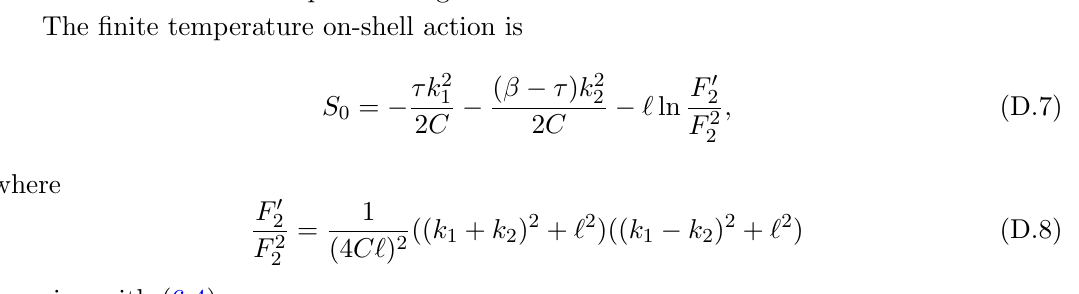
Figure 6 . Full solution at zero temperature with t 1 = 0, t 2 = (cid:25) by the inverse temperature (cid:12) are precisely equivalent to the conditions (6.2). An example of a classical solution is depicted in (cid:12)gure